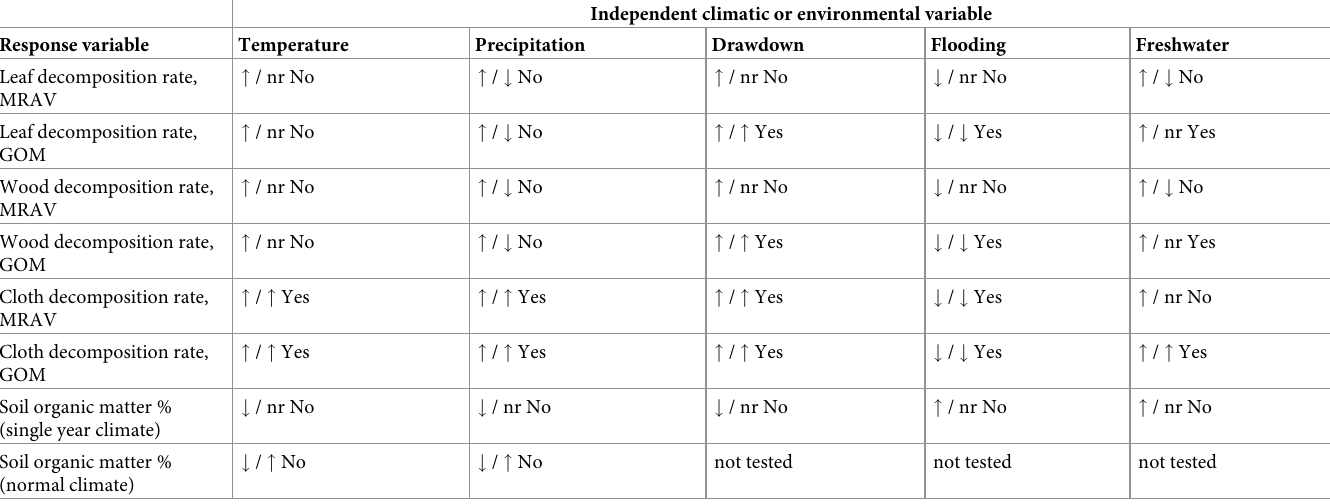
Table 2. Hypothesized vs. actual direction of responses to increasing levels of independent climatic and environmental variables based on conditions during the leaf and wood decomposition (MRAV 2007 and GOM 2011; one year study), and cloth-strip decomposition (upper layer only; MRAV 2007 and GOM 2011; ten day study), or the percent soil organic matter studies (MRAV 2007). Increase or decrease in response is depicted by “ # ” vs. “ " ”, respectively. The hypothesized response is based on predictions stated in related literature. Mean air temperature and total precipitation are included. “Drawdown” is the mathematical complement of flooding (percent time the plot water depth > 1 cm. “Freshwater” indicates the low end of a salinity gradient. “Normal climate” refers to the direction of responses in the climate normal period spanning 1981–2010. “Yes” or “No” indicates if the hypothesis was supported by this study. “nr” indicates no relationship. For the 10-day cloth study, water depth was used a direct indicator of plot flooding/drawdown status. Soil organic matter % � 0.45 = soil organic carbon % [50]. The overall study hypothesis of the study is that environments that increase litter decomposition rates are related to lower soil organic matter